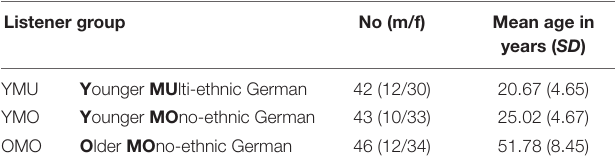
FIGURE 1 | Spectral shapes of the three fricatives [ ç colors. TABLE 1 | Number of participants separated by listener groups with information on ethnic background, gender, and age. Listener group No (m/f) Mean age in